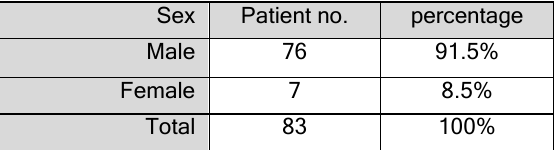
(Table 1) Distribution of Sex